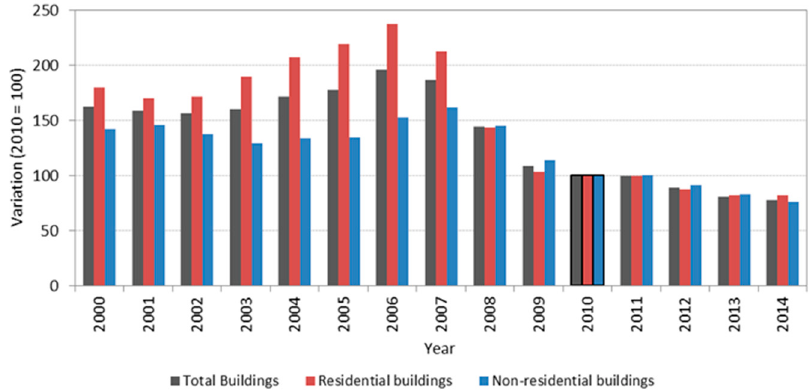
Figure 1. Trend of building permits in European (EU) 28 (2010 = 100). Source: elaboration from EUROSTAT [9].